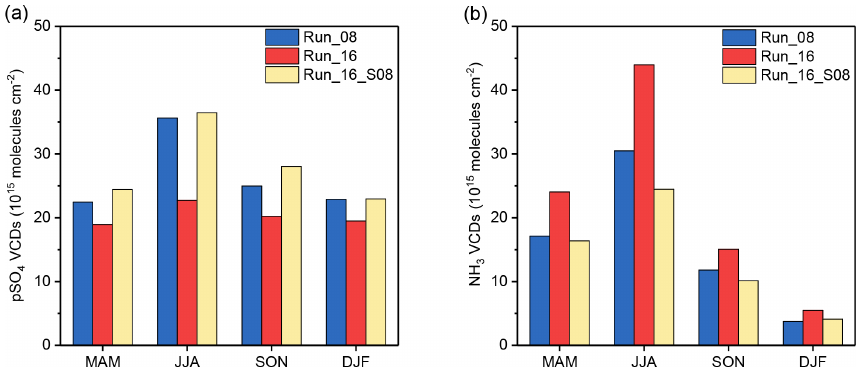
Figure 6. Seasonal patterns of simulated SO 2 − (a) and NH 3 (b) columns for Run_08, Run_16, and Run_16_S08 (the simulation for 2016 4 with SO 2 emissions in 2008) cases. MAM, JJA, SON, and DJF represent spring (March, April, and May), summer (June, July, and